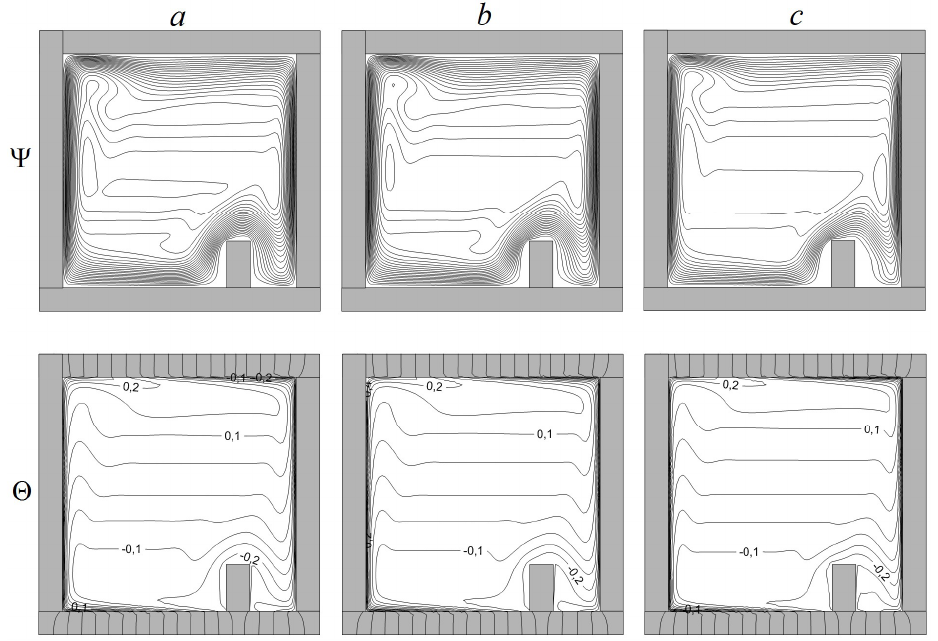
Figure 7. Isolines of Ψ and Θ at ε = 0.9, Pr = 0.7, λ w,air = 10,000, h / L = 0.2: Ra = 10 9 ( a ), Ra = 1.5 × 10 9 ( b ), Ra = 10 10 ( c ).